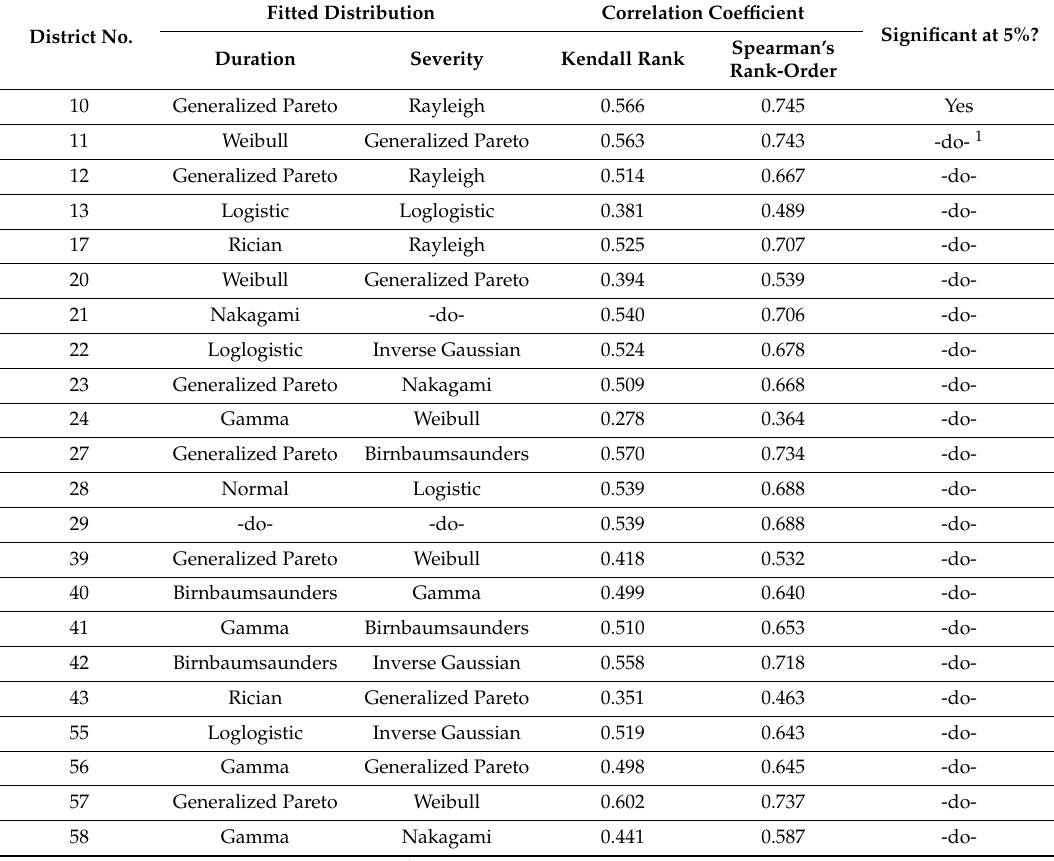
Table 2. Best probability distributions in modelling marginal drought duration and severity computed from Standardized Precipitation Index (SPI)-6 time series. District No.